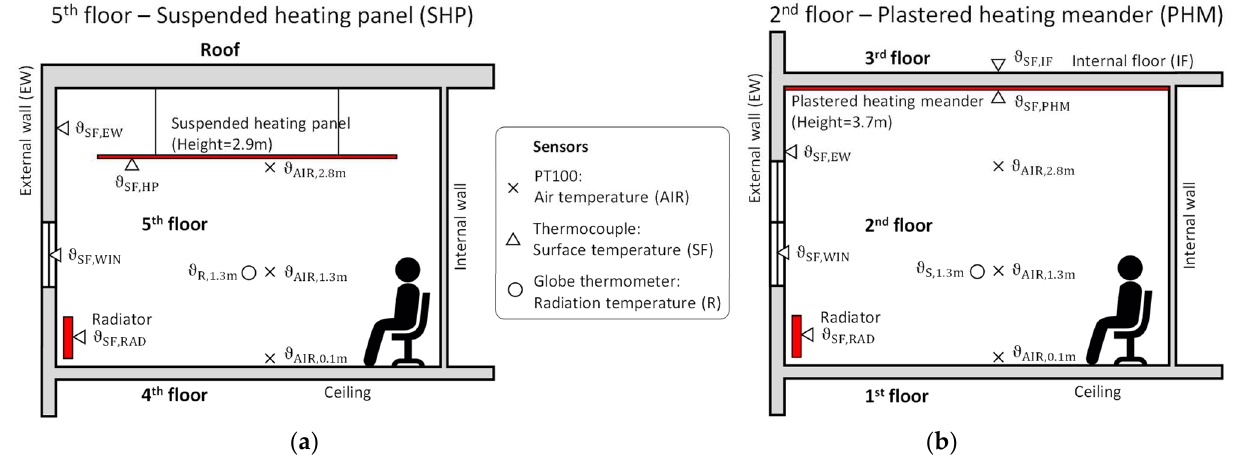
Figure 4. Measurement concept demonstrator for the 5th floor ( a ) and the 2nd floor ( b ).